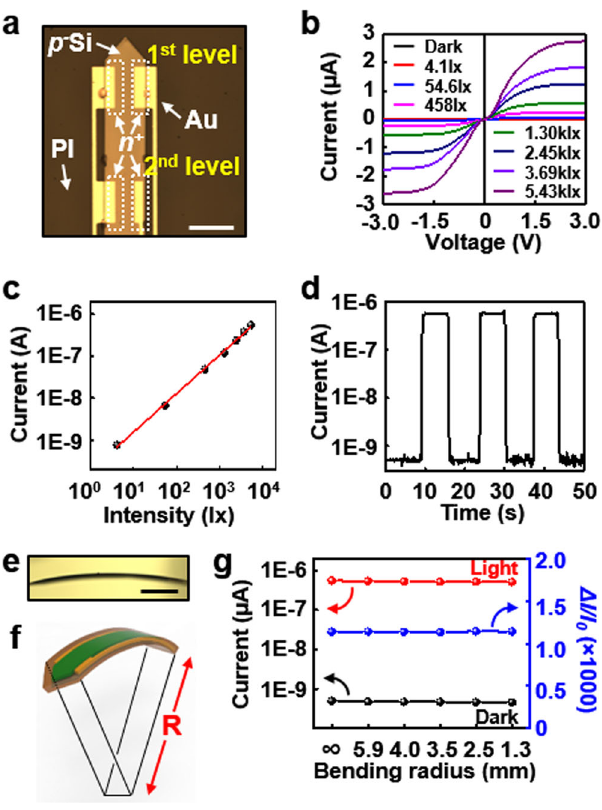
Fig. 3 Characterization of the optoelectronic microprobe. a An optical microscopic image of a microprobe with two photodetectors and the metal interconnects. (scale bar, 300 μ m) b I – V characteristics at different light intensities. c Calibration curve of the Si photodetector. d Dynamic photo response characteristic at 3 V of constant bias. e An optical microscopic side view image of a single probe. (scale bar, 500 μ m) f Schematic illustration of a bent microprobe. g The measured current in dark and under illumination, and calculated Δ I/I 0 at different bending radii